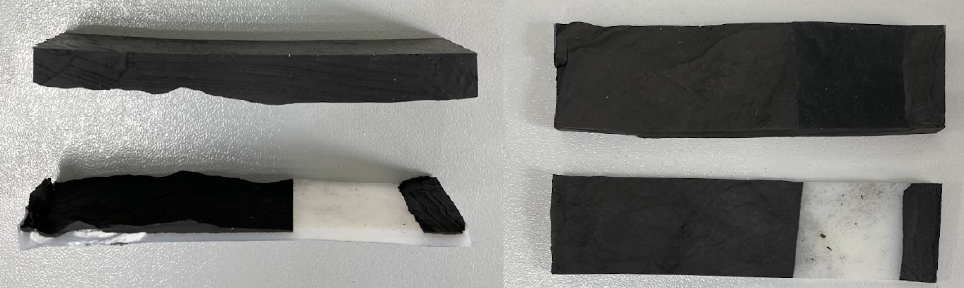
Table 3. Mechanical properties of the elastomeric materials.